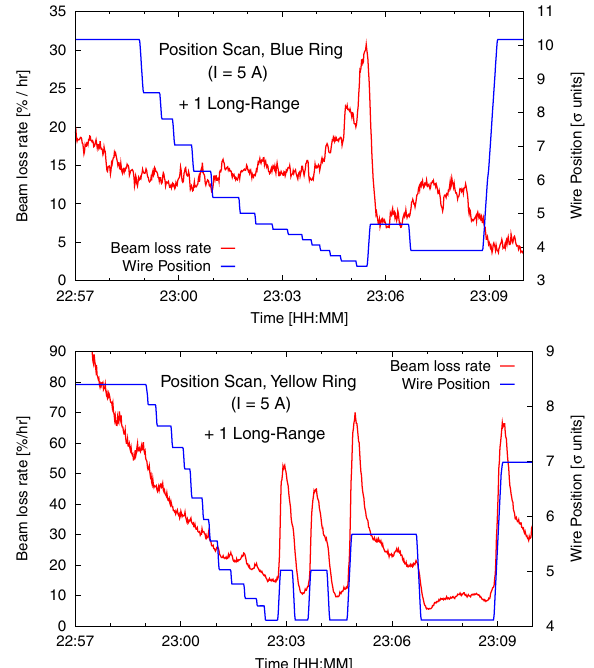
FIG. 19. Beam loss rate for a Blue (top) and a Yellow (bottom) bunch with one long-range interaction, and an additional wire interaction. The wire position varies, and the wire current is constant at 5 A.